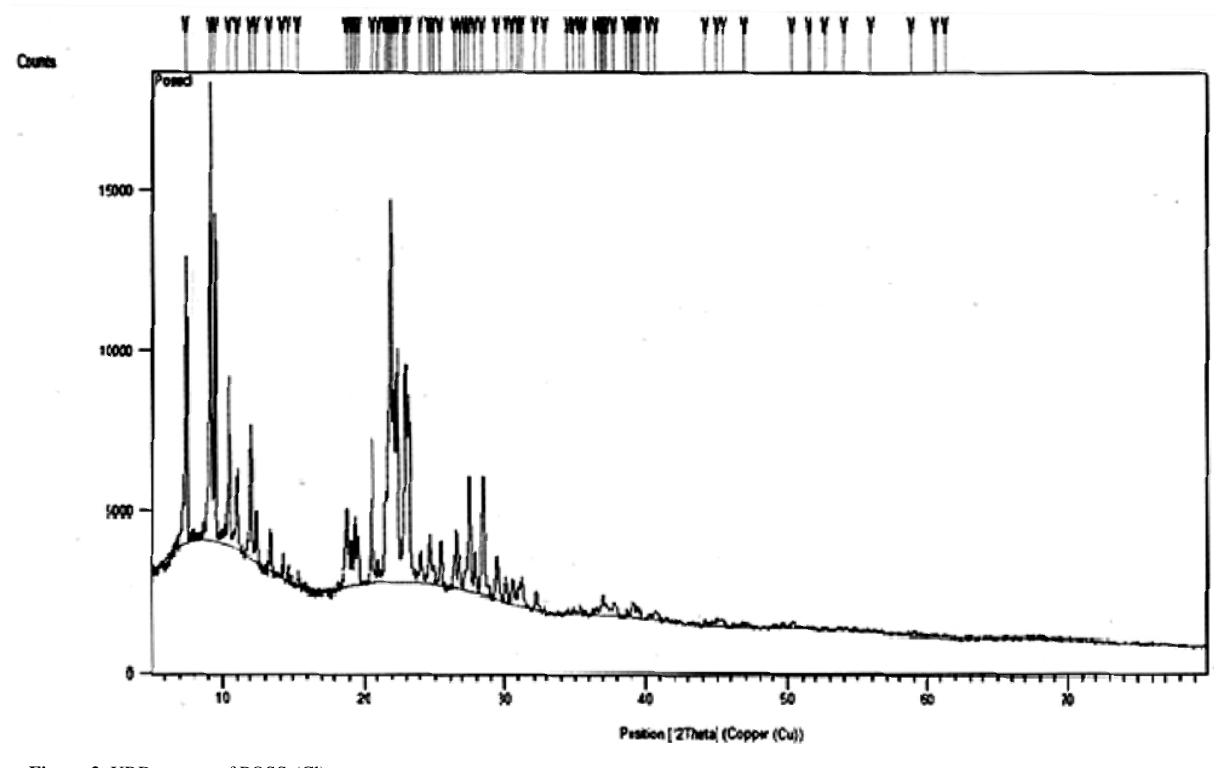
Figure 2. XRD pattern of POSS-(Cl)